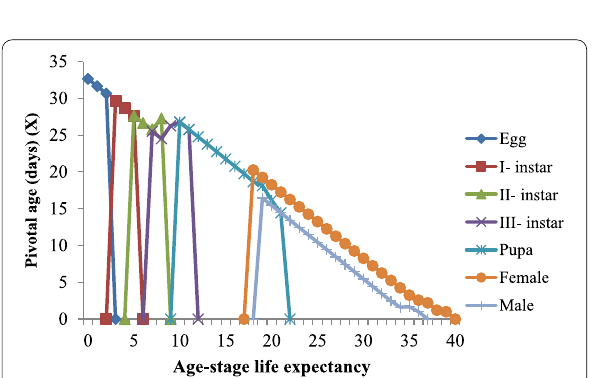
Fig. 3 Age-specific life expectancy ( e xj ) of S. pyrastri on B.